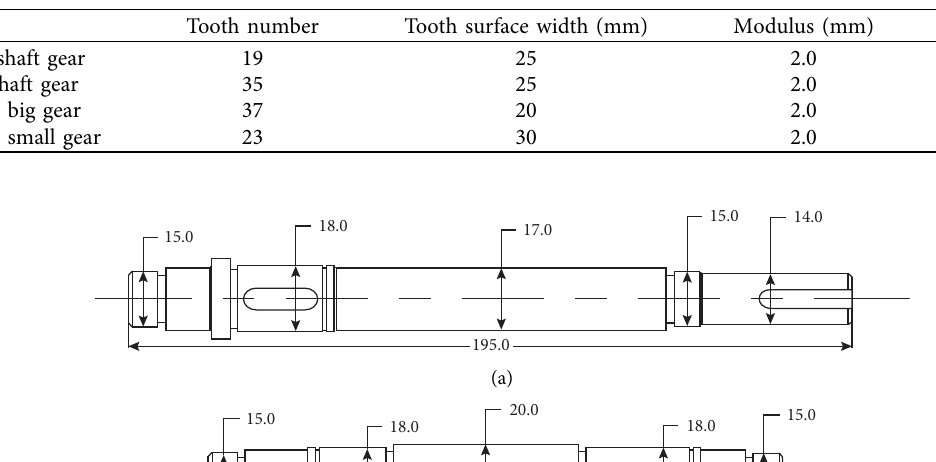
Table 1: Gears at all levels.